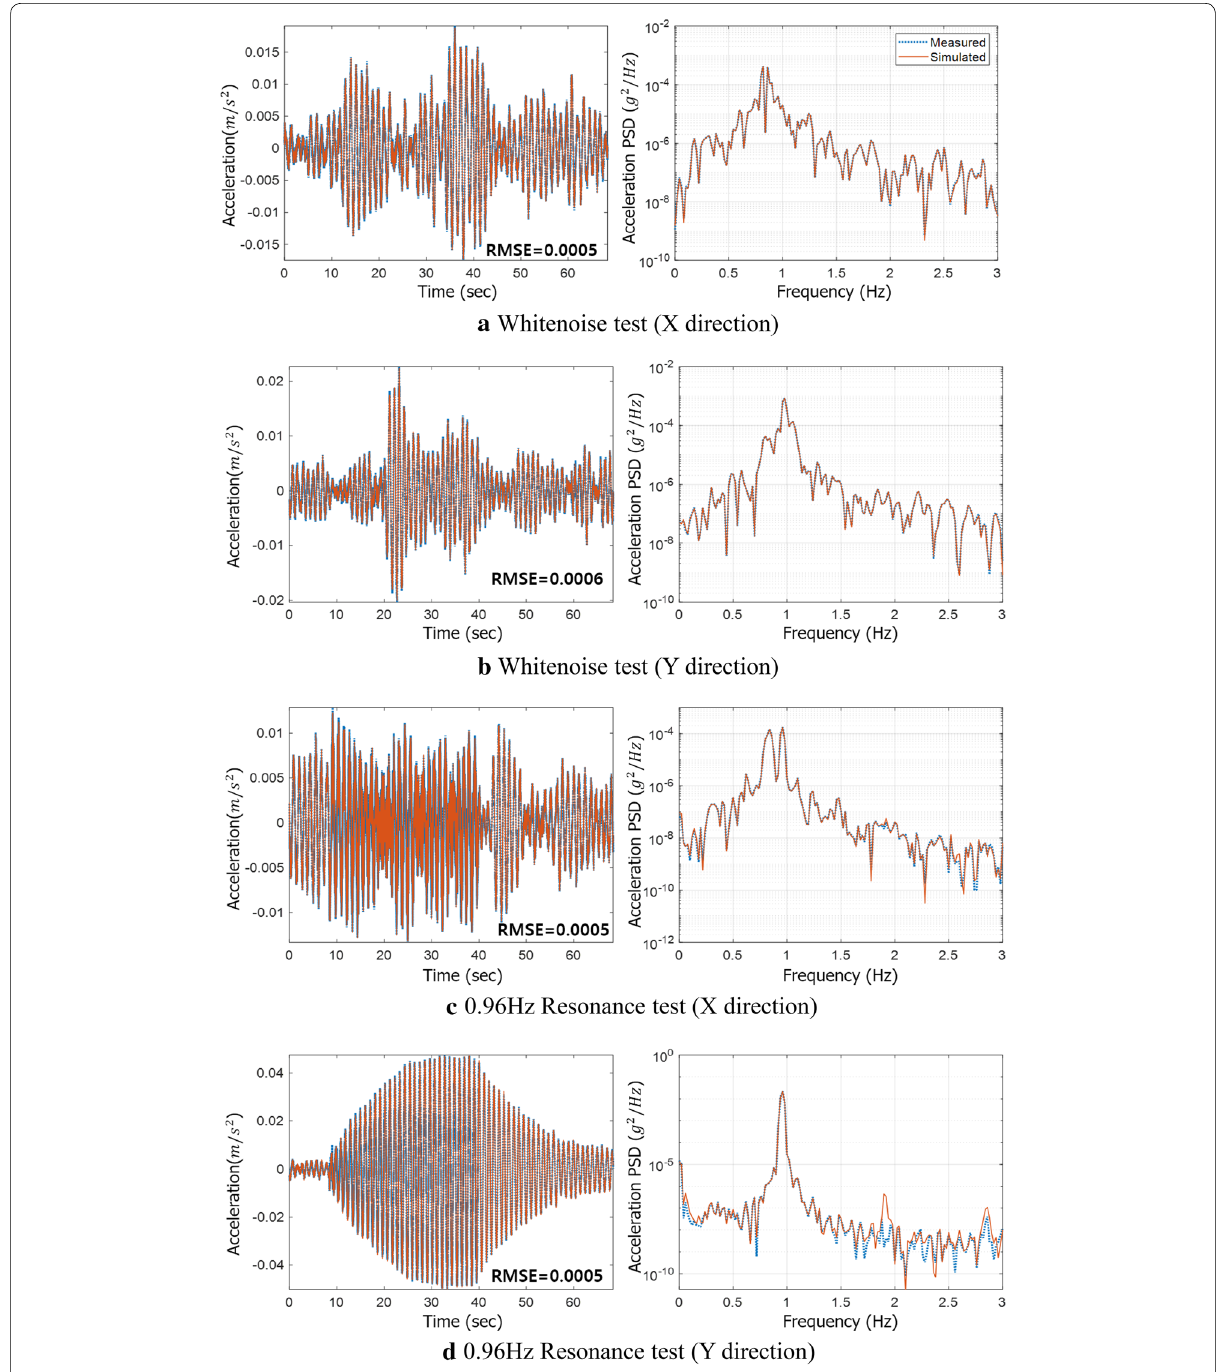
Fig. 9 Simulated acceleration responses at top floor by